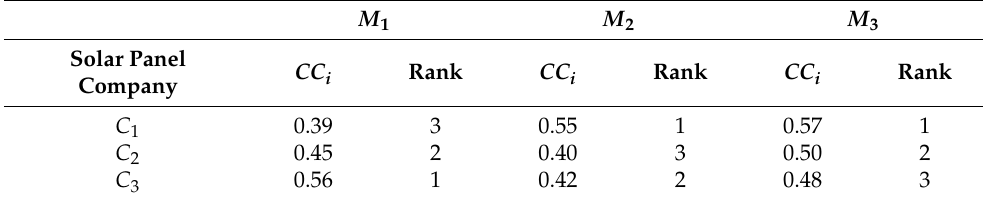
Table 19. CC i of each solar panel company for each manufacturing